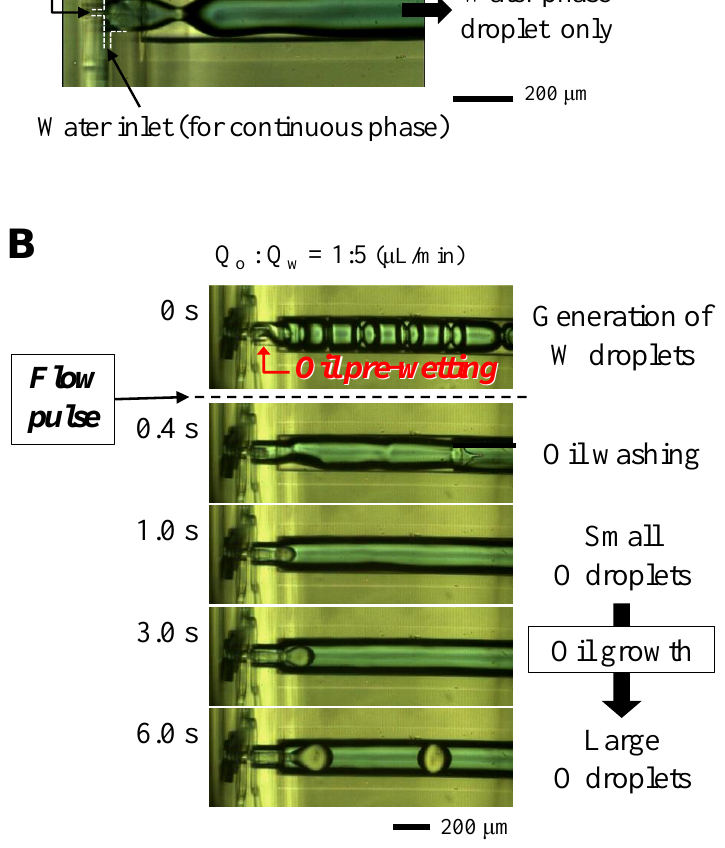
Figure 5. ( A ) Droplet formation result without protrusion structure; ( B ) Recovered formation of oil droplet via oil washing at the junction area with protrusion